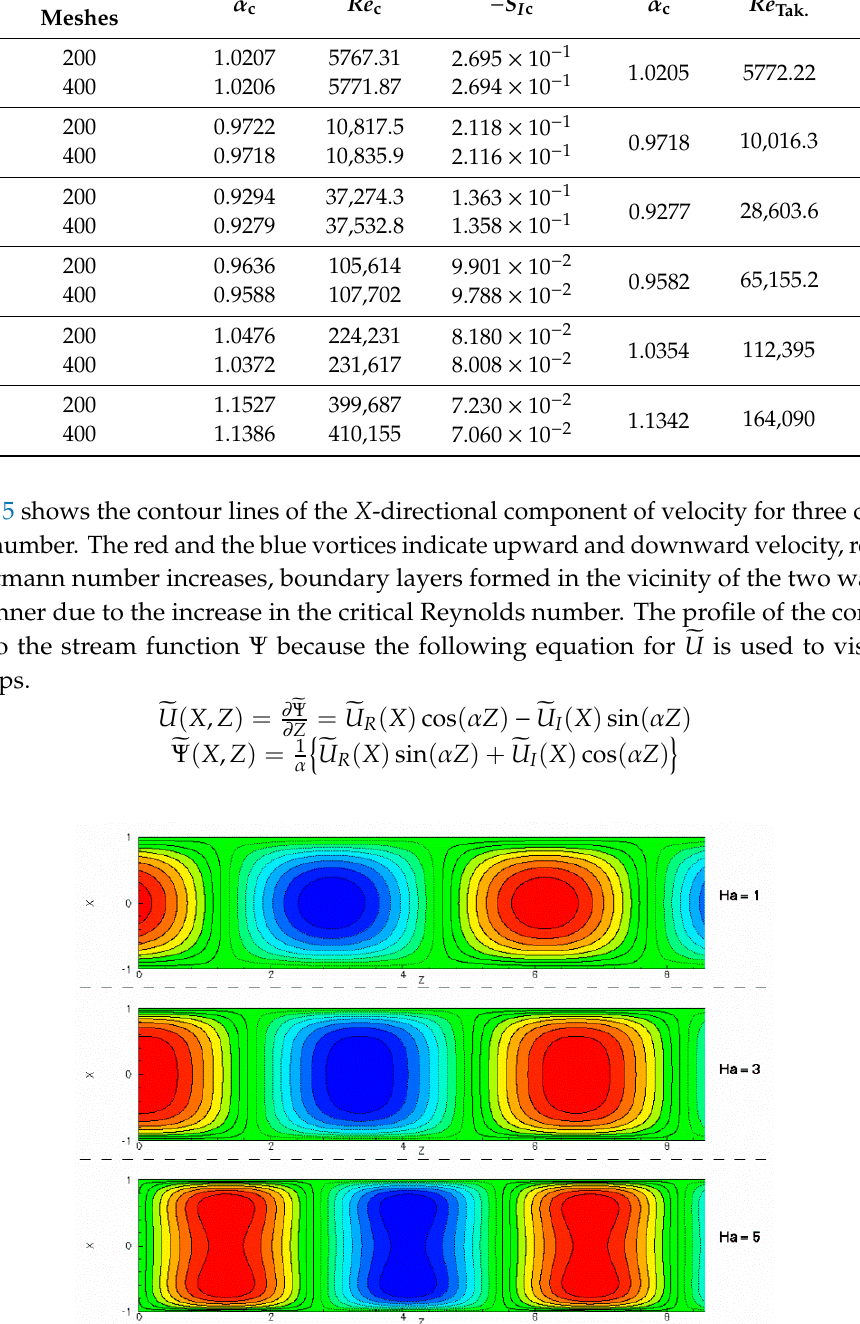
Figure 6. Neutral stability curves in the vicinity of the critical point for Ha = 1. Wavenumber R ey no l d s nu m b e r